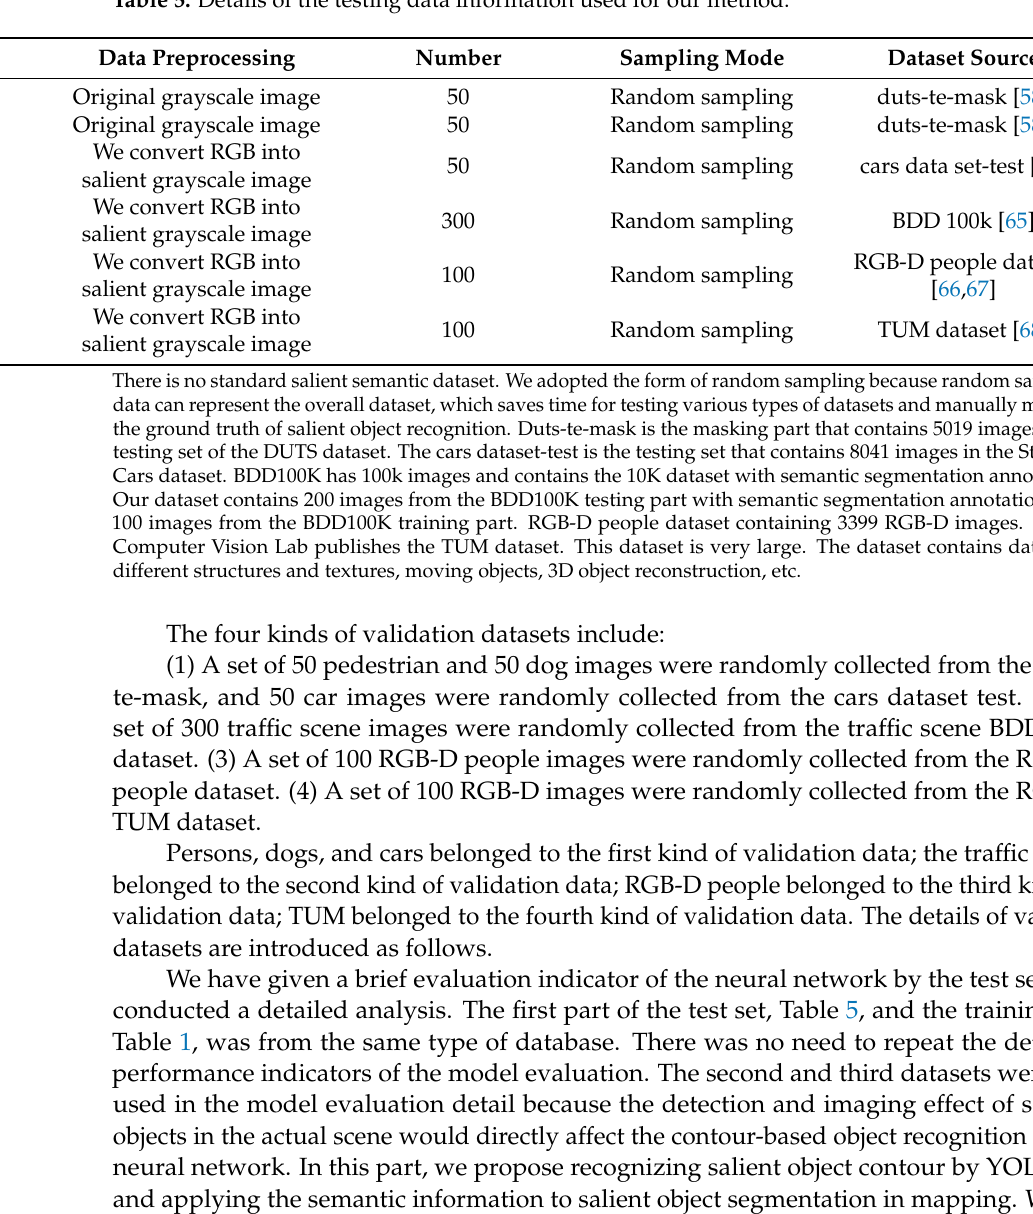
Table 5. Details of the testing data information used for our